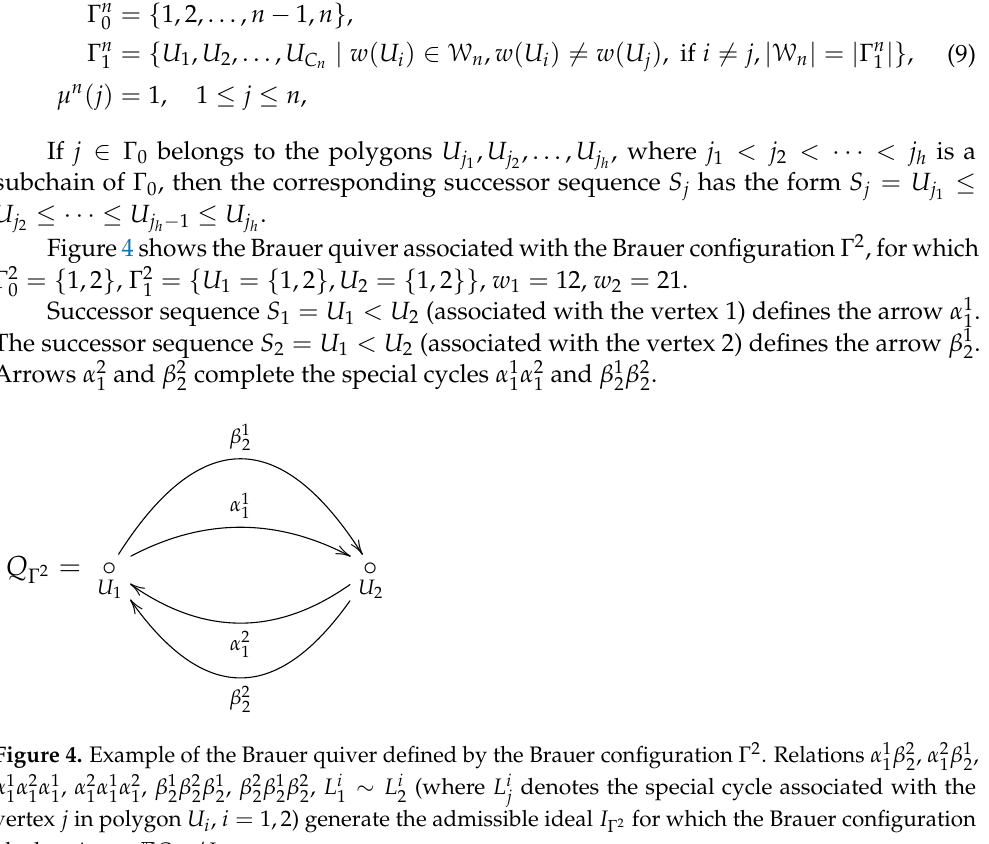
β 2 β 1 , α 2 , 2 2 1 1